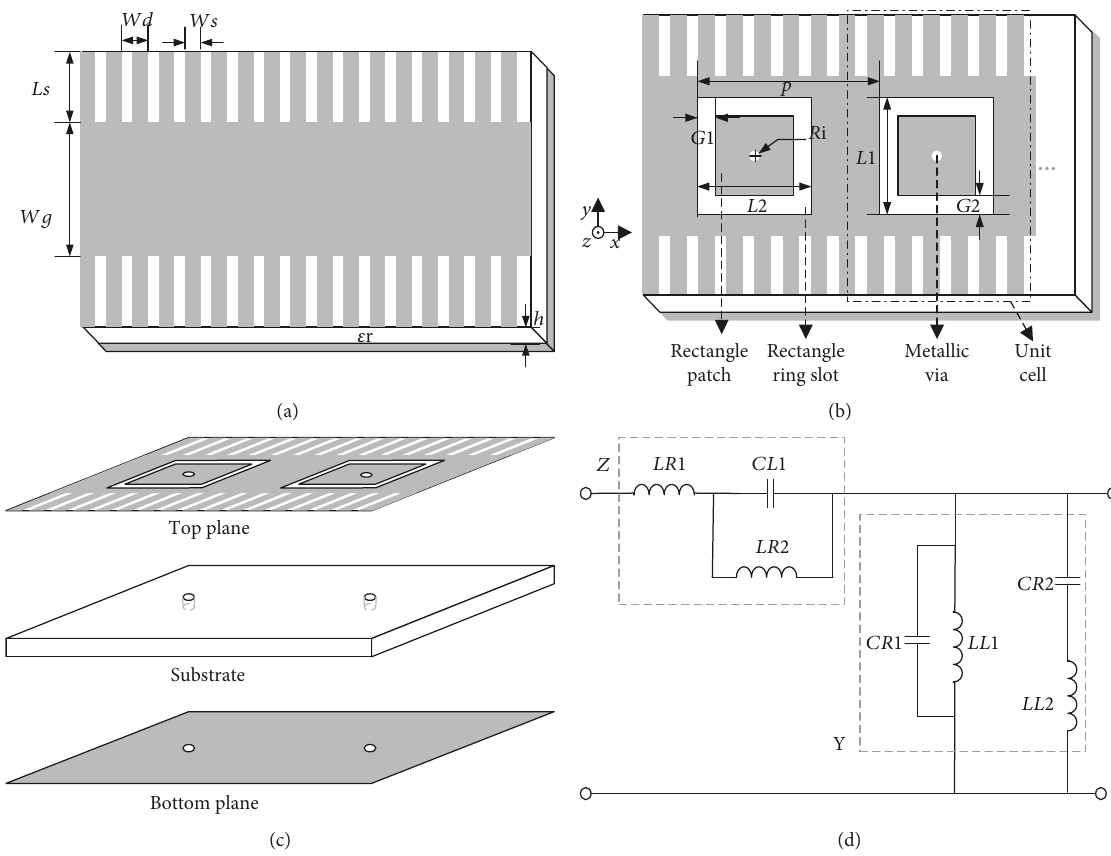
Figure 1: (a) Structure of CSIW. (b) Top view of CSIW-CRLH structure. (c) Exploded view of CSIW-CRLH structure. (d) Equivalent circuit of unit cell CSIW-CRLH structure. L